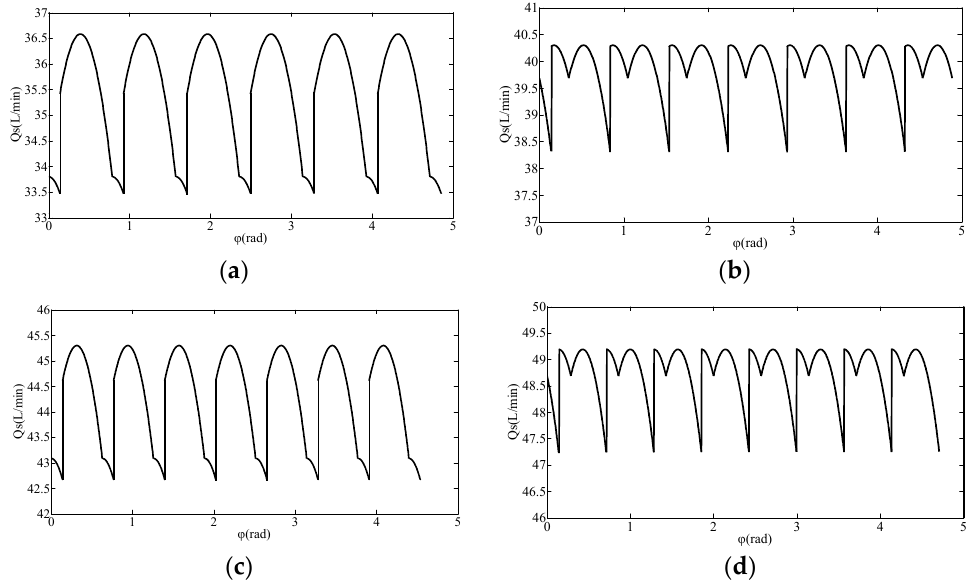
Figure 8. Actual output flow rate of piston pumps with 8~11 pistons for Δφ/2 = φ 0 = 4°. ( a ) output flow of 8-plunger pump; ( b ) output flow of 9-plunger pump; ( c ) output flow of 10-plunger pump; ( d ) output flow of 11-plunger pump.